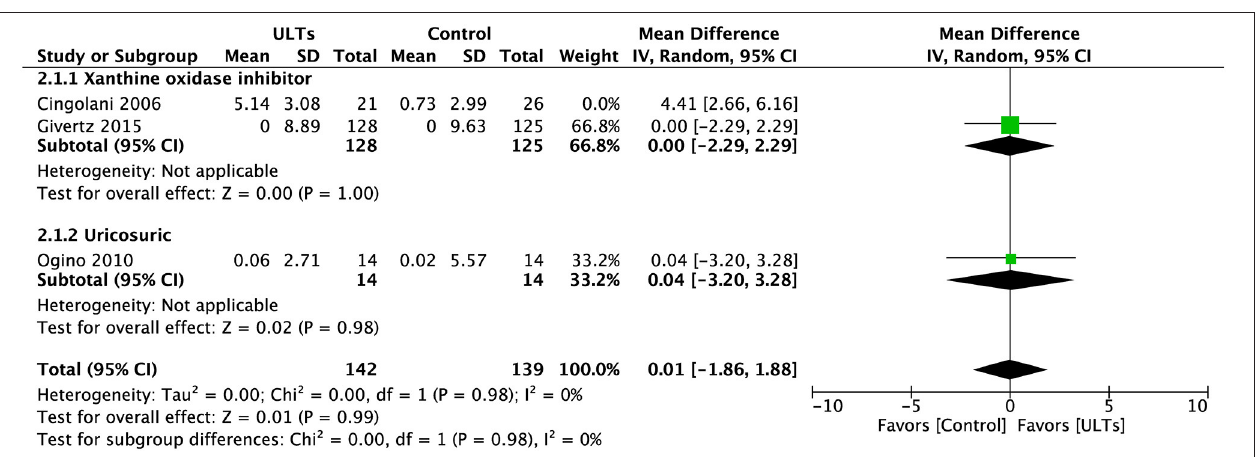
FIGURE 4 | Meta-analysis of left ventricular ejection fraction without Cingolani et al.